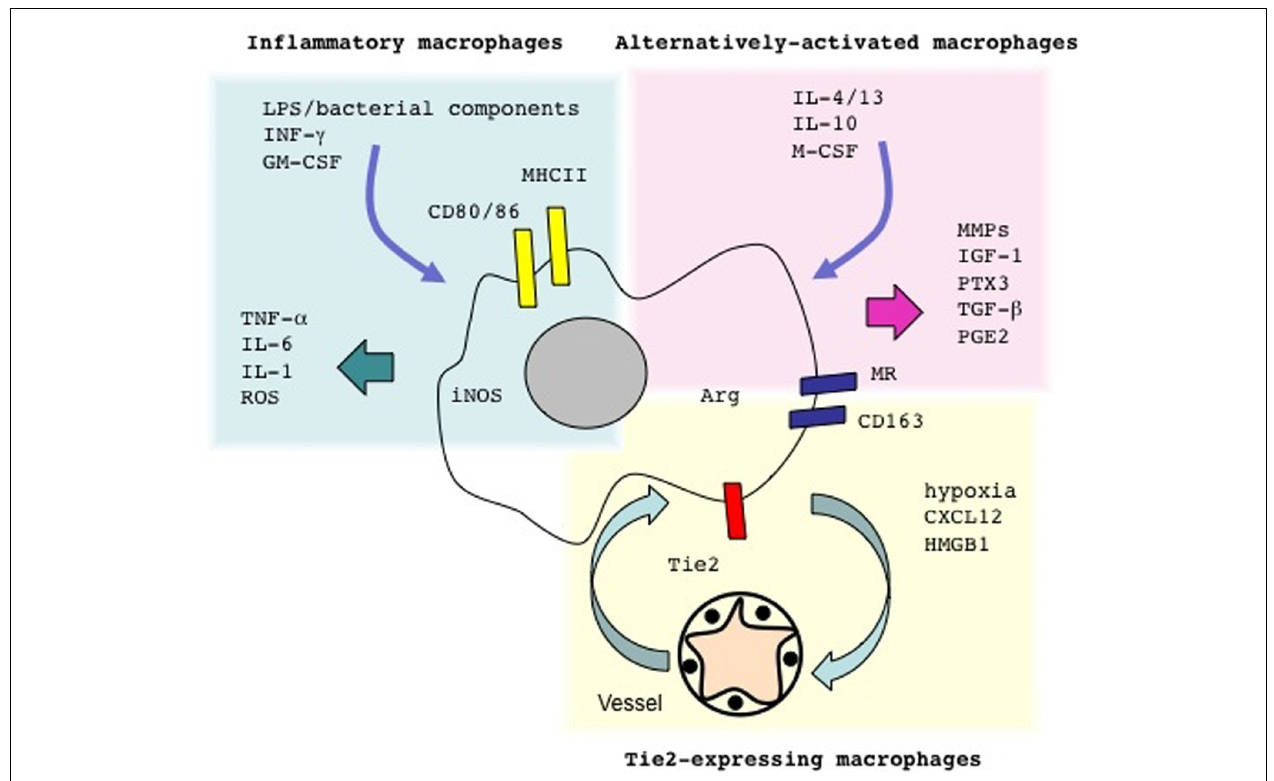
Tie-expressing macrophages in the inflamed tissues.The expression of specific arrays of membrane receptors and the generation of soluble and gaseous messengers reflect the macrophage activation programs. LPS, lipopolysaccharide; IFN- γ , interferon- γ ; GM-CSF, granulocyte macrophage-colony stimulating factor; M-CSF, macrophage-colony stimulating factor; MHCII, major histocompatibility complex class II; CD163, haptoglobin–hemoglobin complex receptor; CD206, mannose receptor;TGF- β , transforming growth factor β ; PGE2, prostaglandin E2; ROS, reactive oxygen